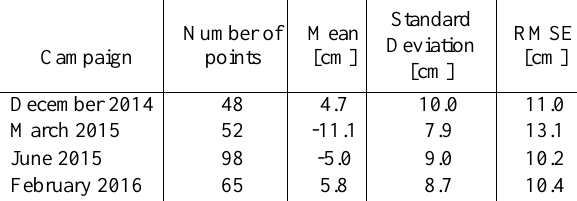
Table 4. Comparison of the SfM derived elevations against independently observed elevations at sample points.